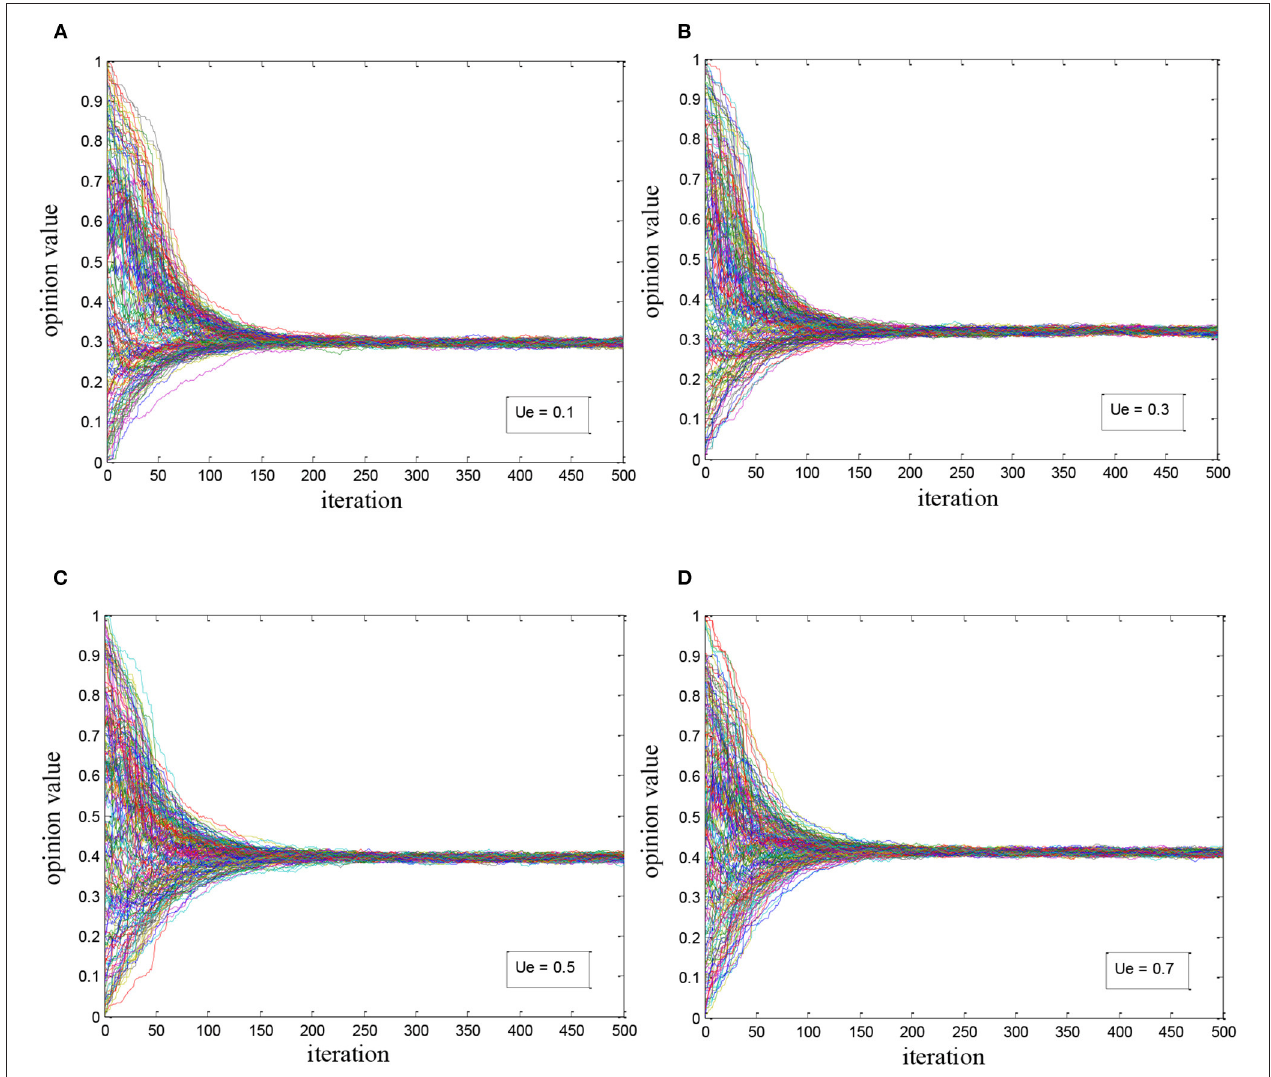
FIGURE 3 | Health opinion evolution considering the super-influencer: (A) u e = 0.1; (B) u e = 0.3; (C) u e = 0.5; (D) u e =